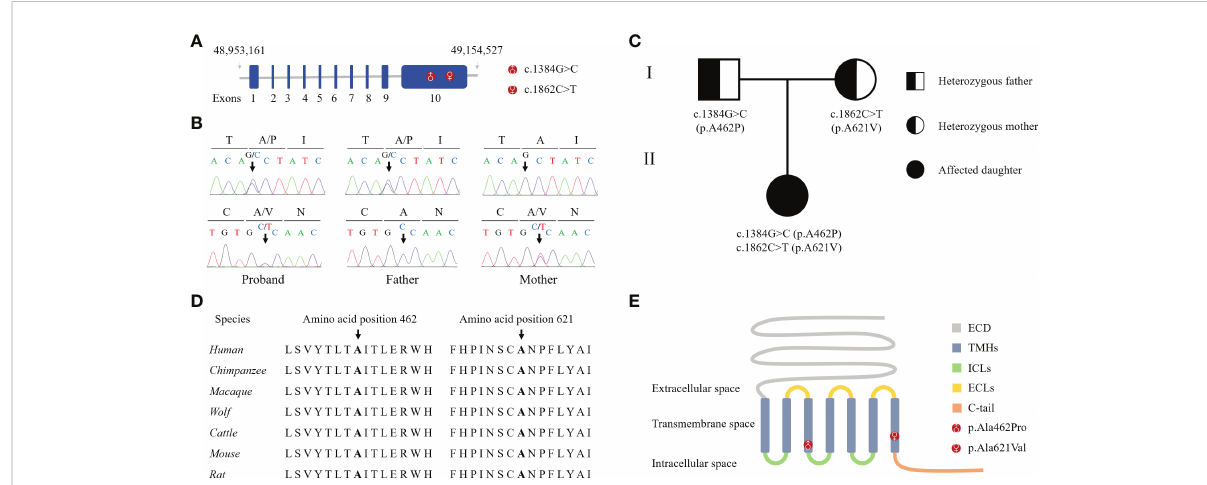
FIGURE 1 Identi fi cation of novel compound heterozygous variants in FSHR . (A) Schematic representation of the hFSHR gene and localization of newly identi fi ed variants. Size of exons is drawn to scale. (B) Validation of NGS by Sanger sequencing. (C) Pedigree of the family examined in the present study. (D) Multiple amino acid sequences alignment of FSHR target sites and their two fl anks across different species. (E) Schematic representation of hFSHR and localization of newly identi fi ed